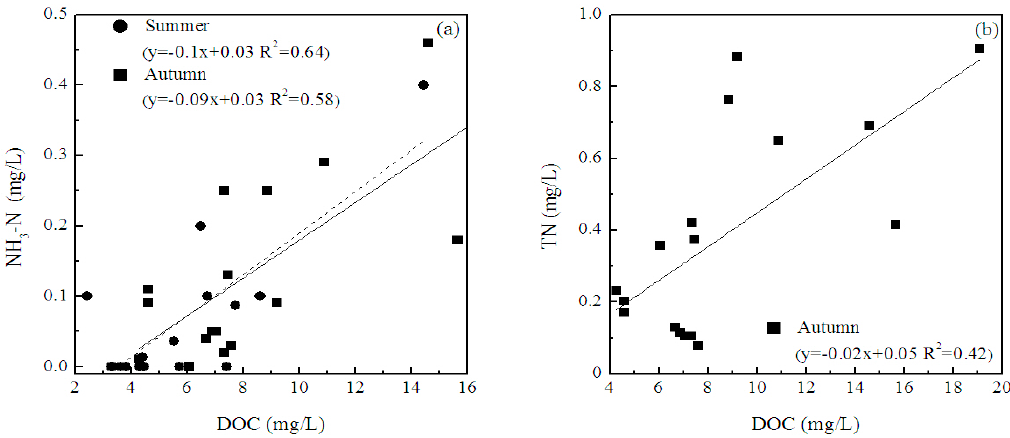
Figure 3. Regression correlation of NH 3 ‐ N, TN and DOC for the riverine waters: ( a ) DOC and NH 3 ‐ N in summer and autumn; ( b ) DOC and TN in autumn.